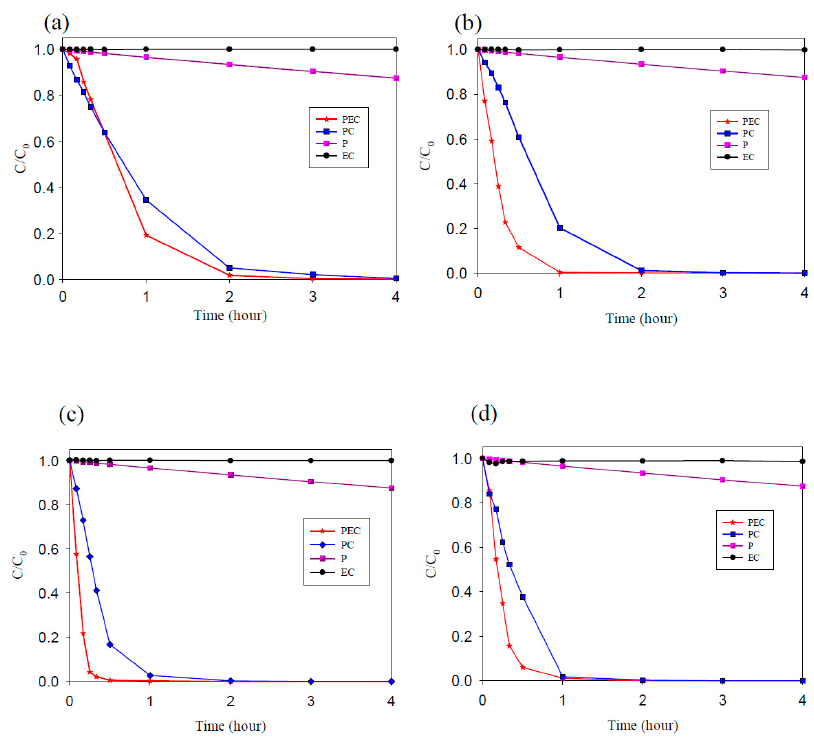
Figure 8. The degradation efficiency of methyl orange ( a ) TNAs, ( b ) Pd/TNAs, ( c ) Pd/TNAs-C, and ( d ) Pd/TNAs-G.